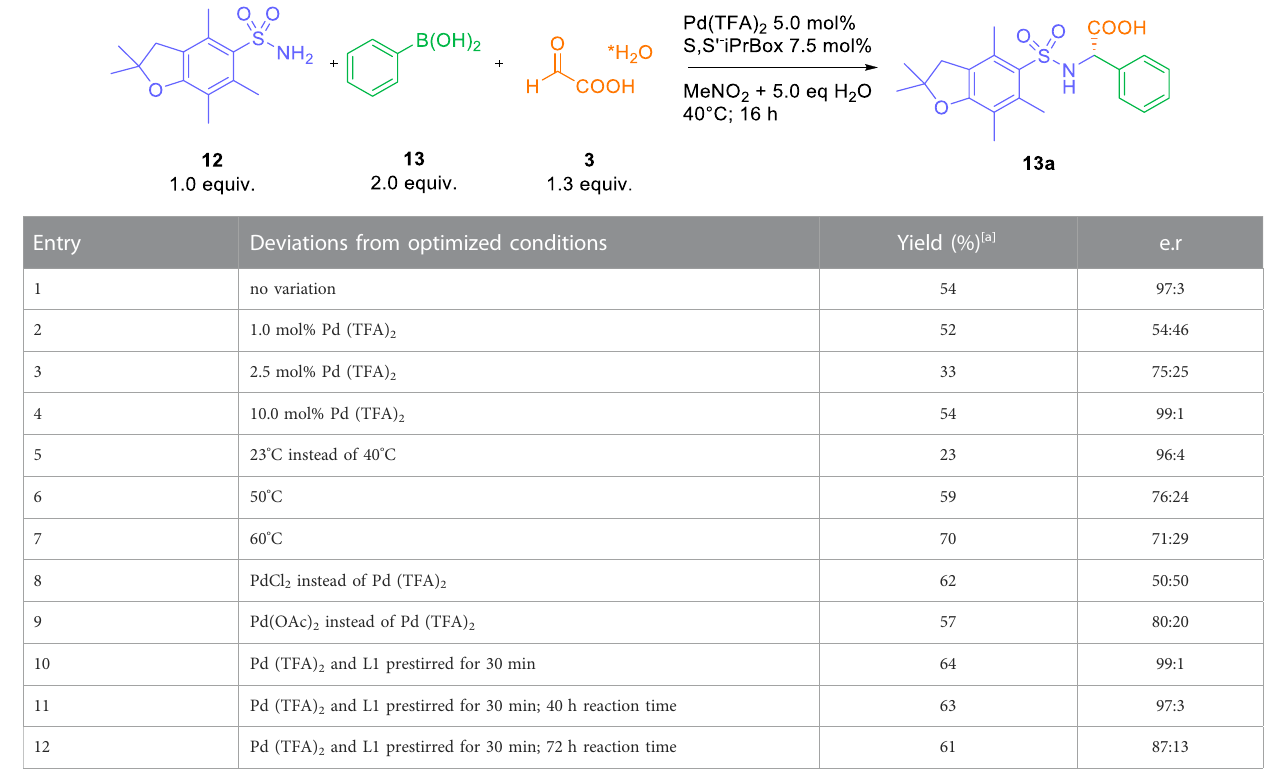
TABLE 3 Reaction parameter